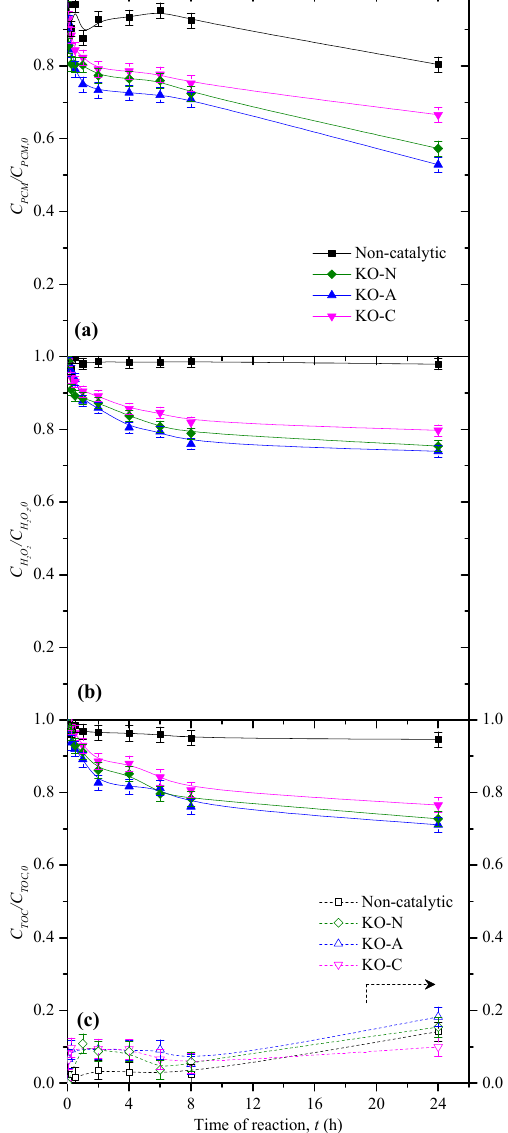
Figure 4. Profiles of the relative concentrations of ( a ) paracetamol (PCM), ( b ) H 2 O 2 and ( c ) TOC during the catalytic wet peroxide oxidation (CWPO) of PCM with the non-pillared clays prepared from the natural clay extracted from the Kokshetau deposit. Operating conditions: C PCM = 100 mg L − 1 , C H 472 mg L − 1 , C cat = 2.5 g L − 1 , initial pH = 3.5 and T = 80 °C.